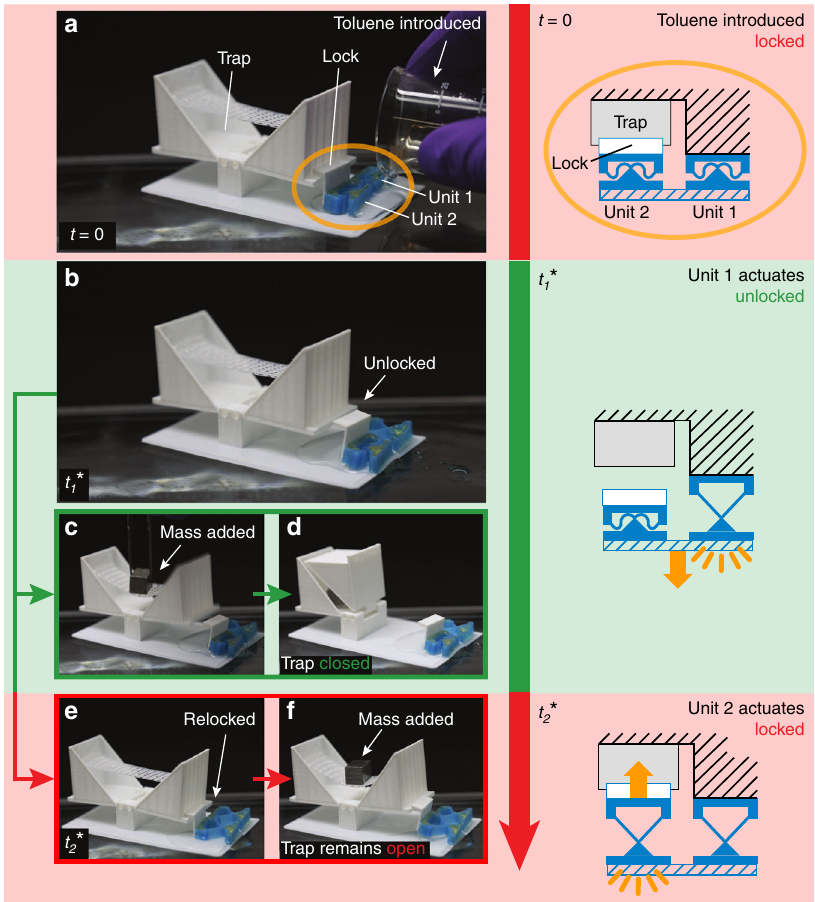
- t (cid:4) < t (cid:4) - t (cid:4) ). a Toluene is applied to a fl ytrap-inspired system which is prevented from 1 2 1 mass ), which unlocks the lobe. c , d If a mechanical 1 ) and relocks the lobe; adding a mechanical load 2